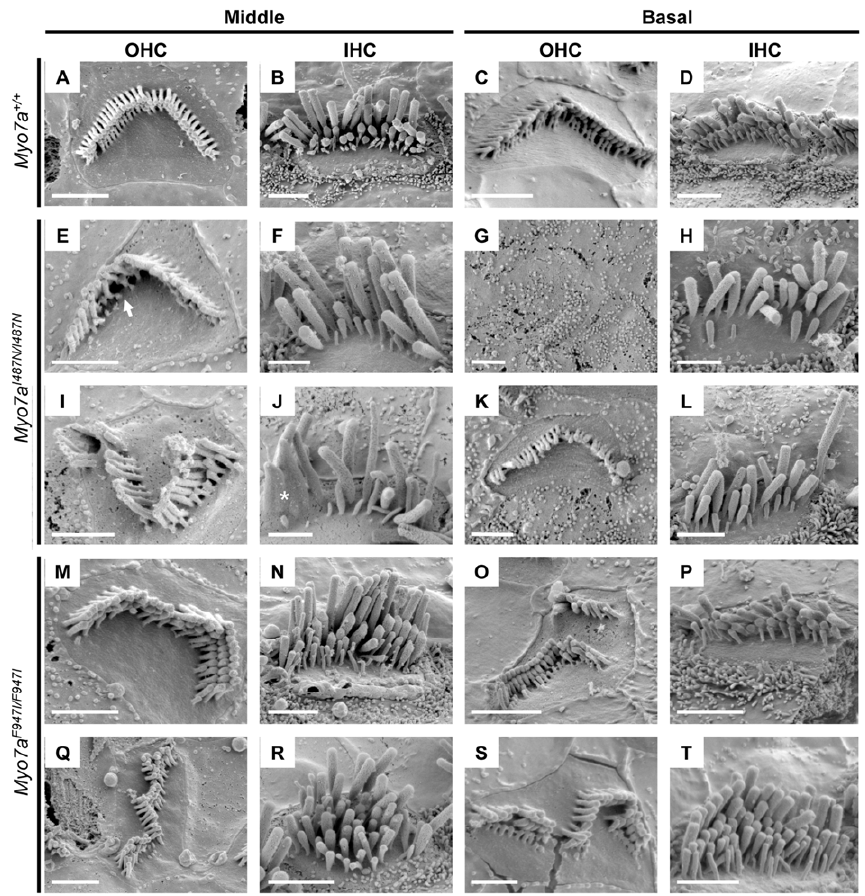
Figure 6. Scanning electron micrographs of inner (IHC) and outer (OHC) hair cells from 8 week old mice. ( A–D ) Myo7a + / + , ( E–L ) Myo7a I487N/I487N ewaso and ( M–T ) Myo7a F947I/F947I dumbo mice at the middle and basal cochlear level. OHC bundles of Myo7a I487N/I487N ewaso mutants appear to have a regular V shaped array, however are missing the majority of their inner-row stereocilia at the middle level (arrow head in E). This is more severe at the basal level where many OHC bundles are missing ( G ). This phenotype is more severe in Myo7a F947I/F947I dumbo mutants, where OHC bundles are disoriented, forming an array of OHC-type bundles ( M, Q, O and S ). Many Myo7a I487N/I487N ewaso IHC bundles are affected at this age, with less numbers of stereocilia within the bundle and those remaining often showing signs of fusion (asterisk in J). The IHC bundles in Myo7a F947I/F947I dumbo contain additional rows of stereocilia, however do still maintain a staircase-like structure ( N, R, P and T ). Scale bar; 2 m M.